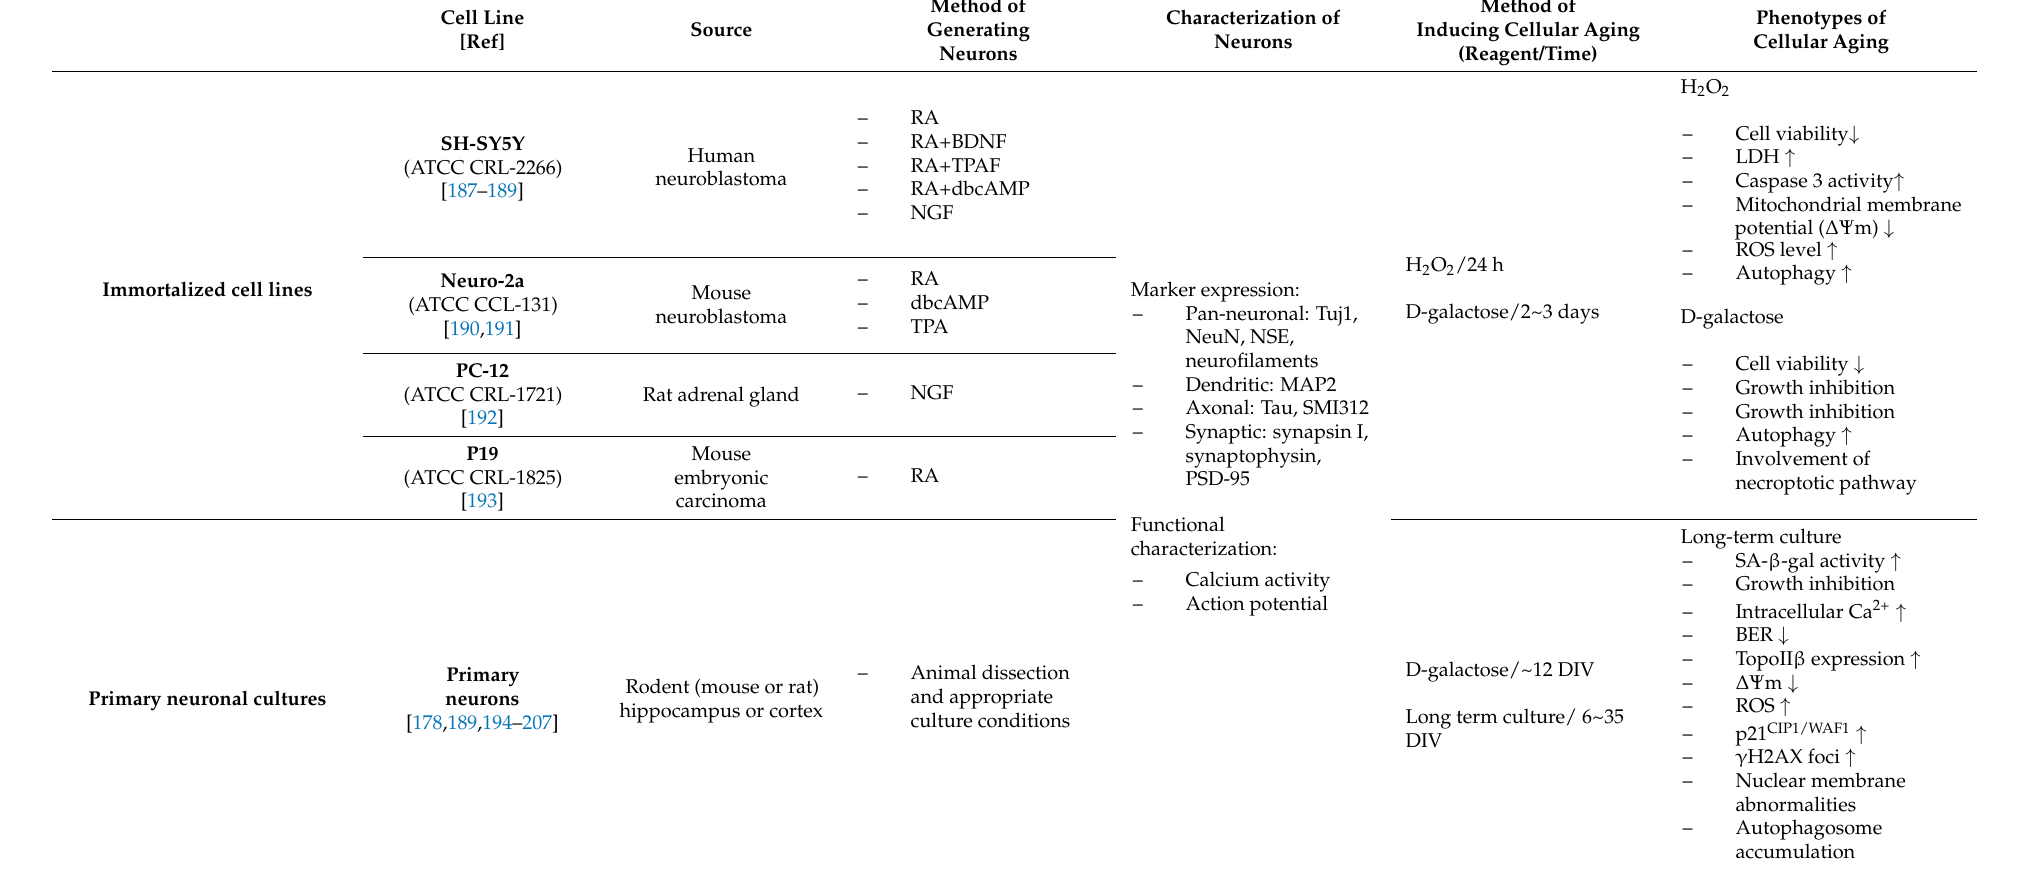
Table 1. The characteristics of the in vitro cell models that can be used to study neuronal